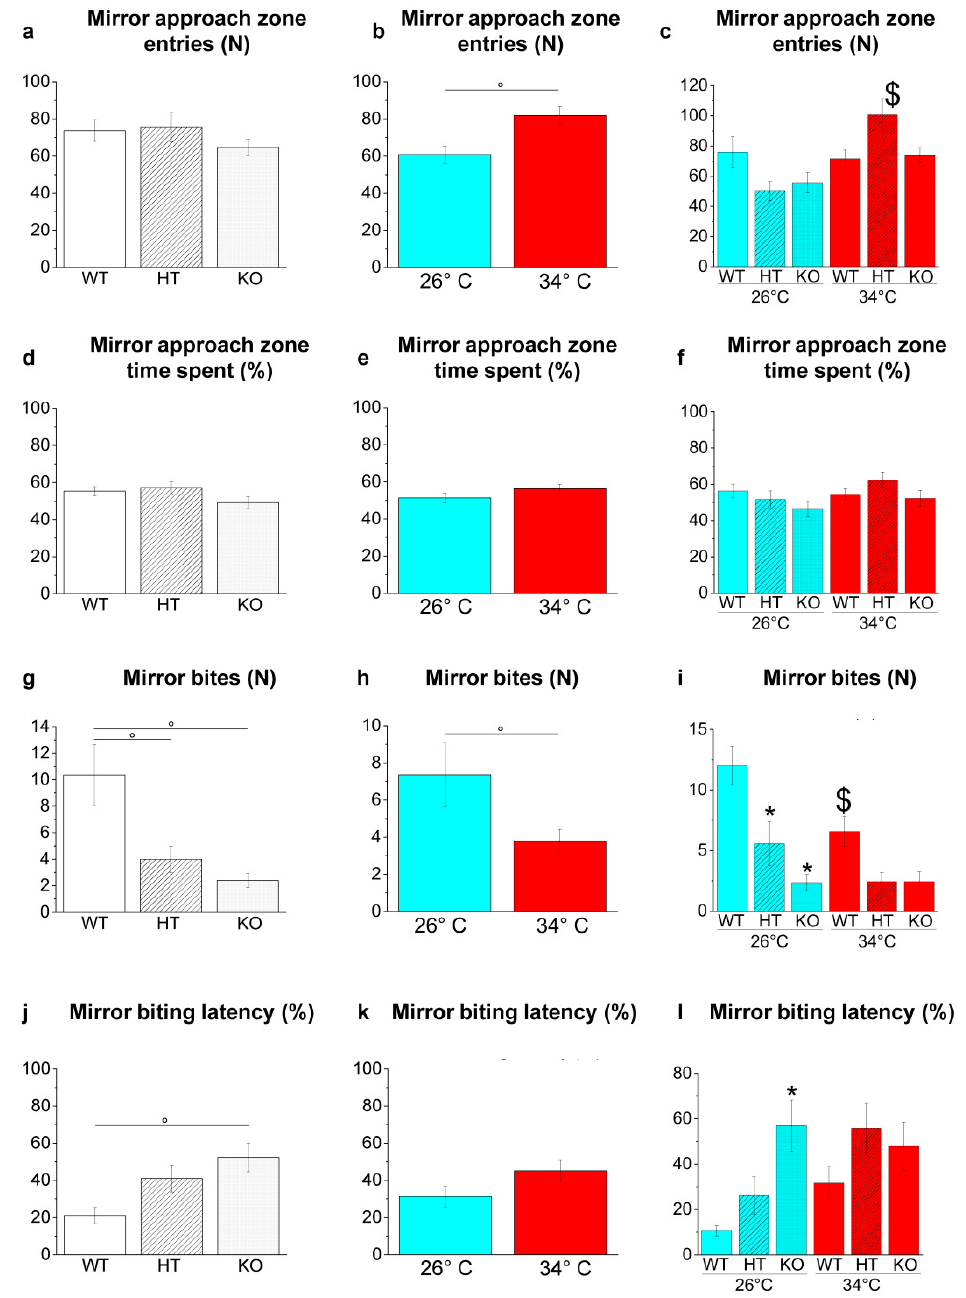
Figure 13. Aggressive behaviour in the MBT. ( a – c ) Entries in mirror approach area; ( d – f ) time spent in mirror approach area expressed as percentage of total time; ( g – i ) mirror bites; ( j – l ) mirror-biting latency. The data are expressed as mean ± S.E.M. and analysed by two-way ANOVA with Bonferroni post hoc correction. p ≤ 0.05, °; *, HT26 vs. WT26 or KO26 vs. WT26; $, WT34 vs. WT26, HT34 vs. HT26 or KO34 vs. KO26. p values and symbols used in the figure are shown in Table S26. N = 14. Blue and red colours refer to 26 °C and 34 °C, respectively.